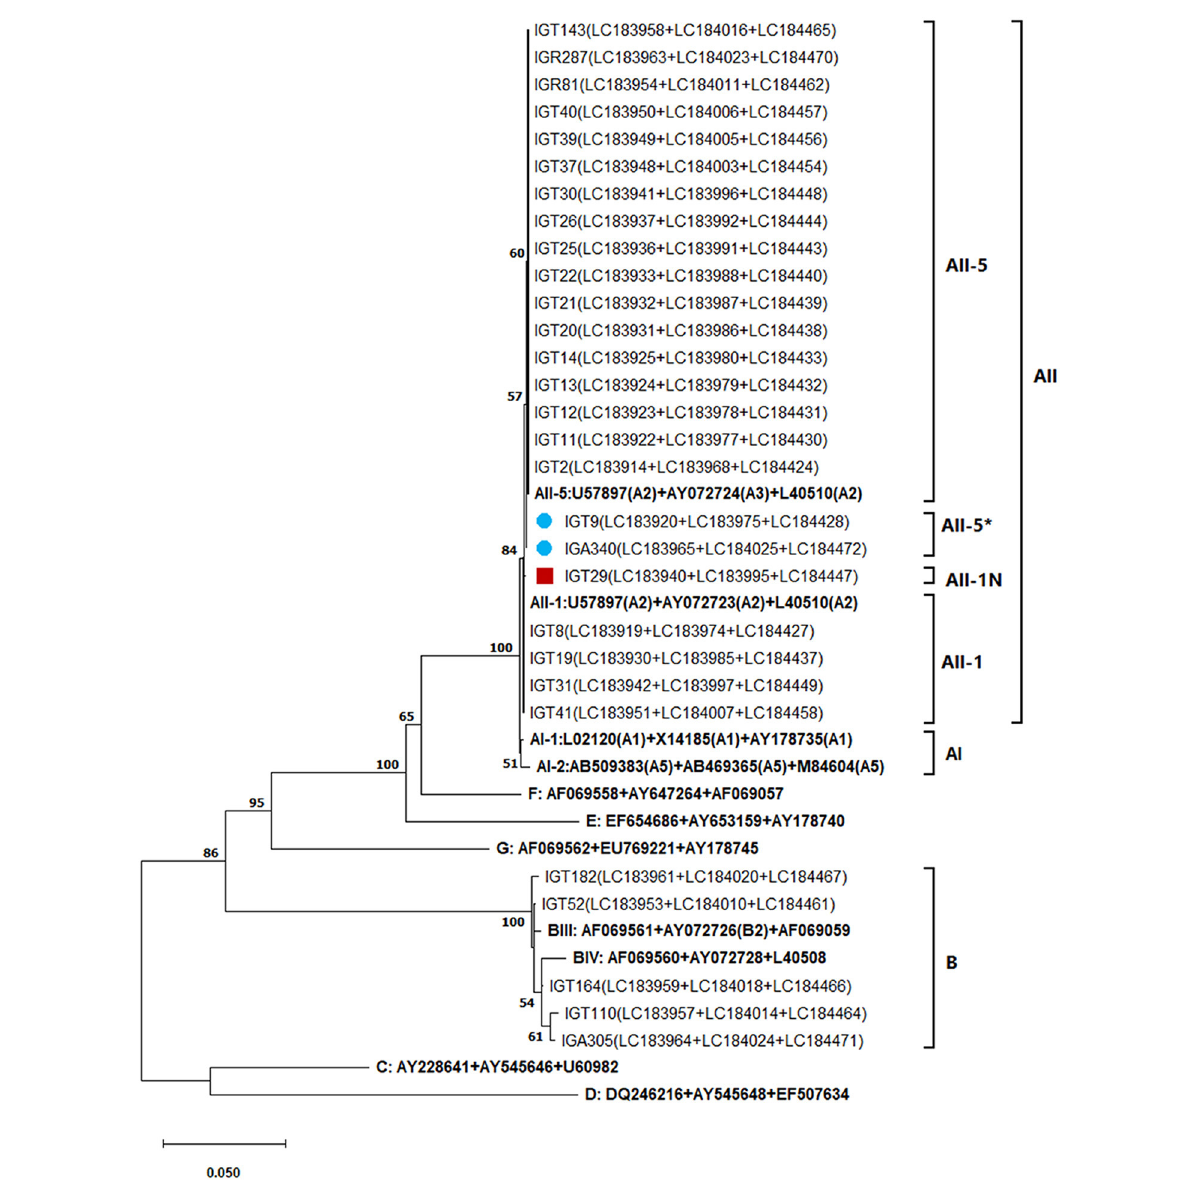
FIGURE4 The phylogenetic analysis of the concatenated tpi , bg , and gdh nucleotide sequences of Giardia duodenalis using the maximum likelihood method (ML) and Tamura 3-parameter model (38) (T92 + G + I). The analysis involved 40 nucleotide sequences: 29 concatenated ( tpi + bg + gdh ) nucleotide sequences retrieved from this study compared with 11 known multilocus genotype reference sequences reported in previous studies (17, 40, 41) are indicated in bold. The red-filled square represents the new MLG of assemblage A reported in this study and the blue-filled circles indicate the one nucleotide substitution in A3 compared with the AII-5 MLG of assemblage A based on the modified numerical MLG reviewed in Cai et al. (4). The final dataset contained 1,395 positions. The percentage of trees in which the associated taxa clustered together (achieved from 1,000 replicates) is shown next to the branches, only bootstraps values > 50% are demonstrated. A discrete Gamma distribution was used to model evolutionary rate differences among sites [5 categories ( + G , parameter = 0.3229)]. The rate variation model allowed for some sites to be evolutionarily invariable [( + I ), 37.78% sites]. The scale bar represents substitutions per nucleotide. Evolutionary analyses were conducted in MEGA X